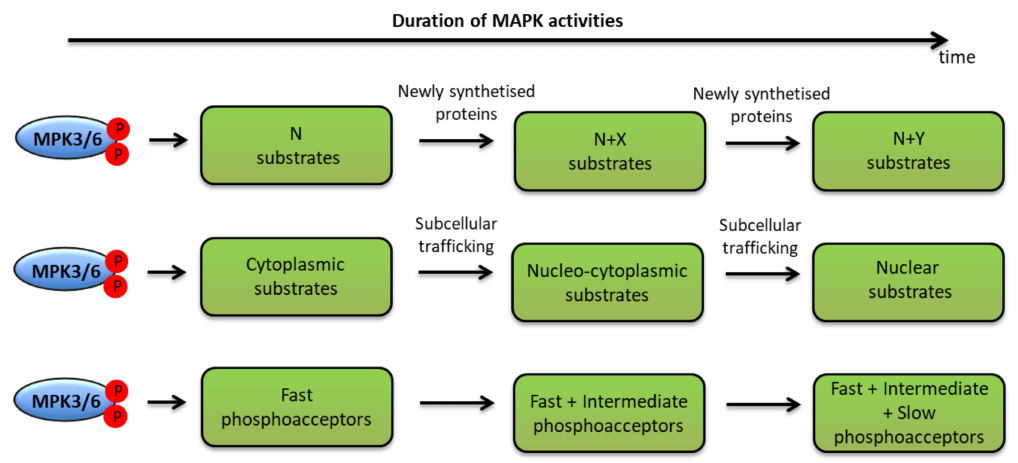
Figure 6. The temporal phosphocode of MPK3 / 6. Di ff erent processes, explaining how durable activities of MPK3 / 6 might impact the scope of their phosphorylation sites, substrates and functions, are represented: either the scope is modified by newly synthesized substrates (upper line), or by subcellular tra ffi cking allowing new meetings between the kinases and their substrates (middle line), or by the existence of phosphosites which are phosphorylated with di ff erent kinetics (lower line). For detail, see the main